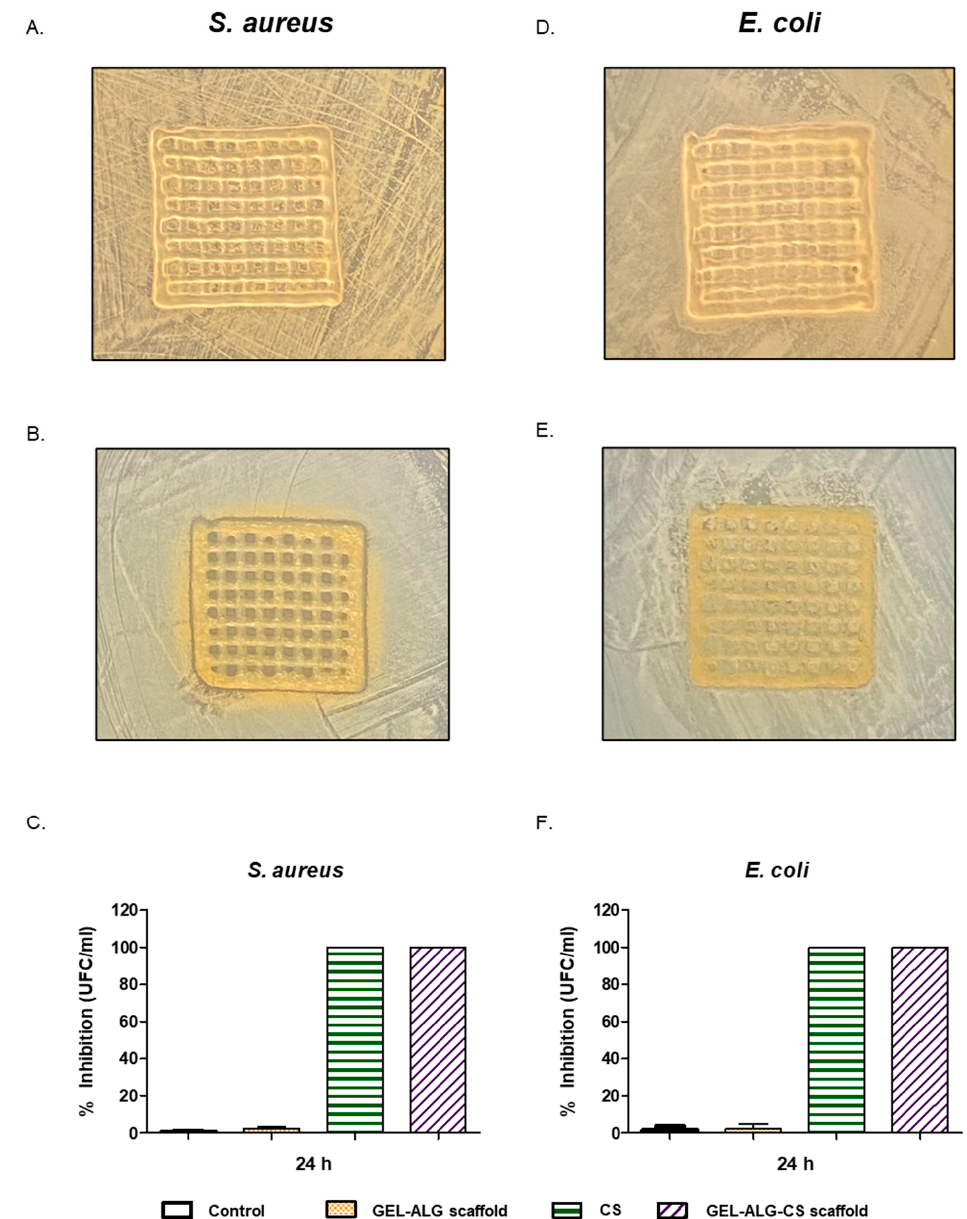
Figure 8. Antimicrobial activity: GEL–ALG scaffold ( A ) and GEL–ALG–CS scaffold ( B ) against S. aureus by disk diffusion method. ( C ) Percentage of growth inhibition of S. aureus , evaluated by the dilution method. GEL–ALG scaffold ( D ) and GEL–ALG–CS scaffold ( E ) against E. coli by disk diffusion method. ( F ) Percentage of growth inhibition of E. coli , evaluated by the dilution method.